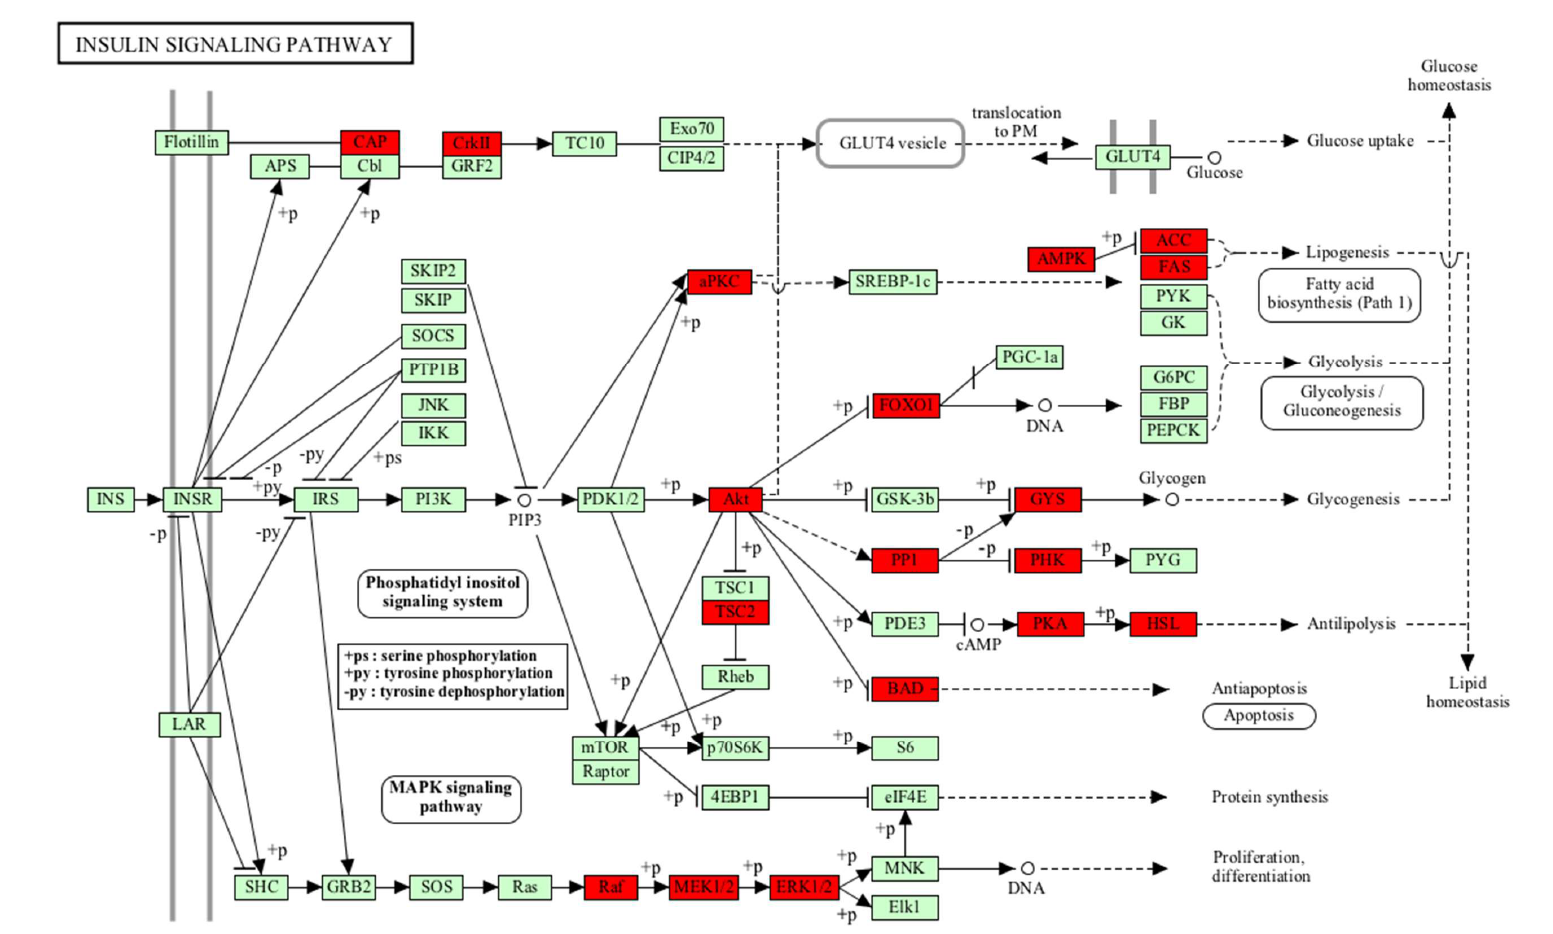
Figure 1. Insulinsignalling pathway activated in retina and RB. Akt mediated downstream signalling of FOXO1 and BCL-2 antagonist of cell death (BAD) play different roles in retina and retinoblastoma. The insulin pathway has a cell survival role rather than acting as a storage pathway in retina and retinoblastoma.